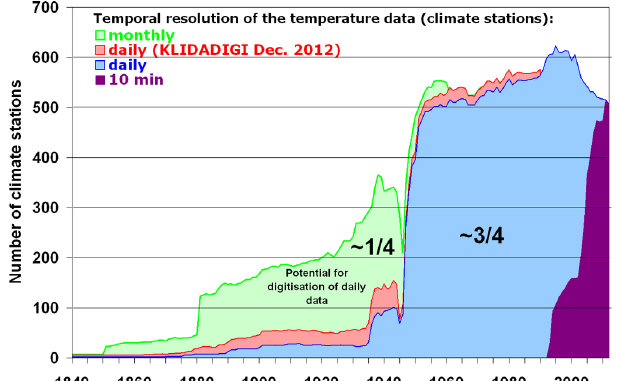
Figure 1. Number of temperature stations in the data base with spe- cific temporal resolution in the database. The blue area indicates the amount of data that was already digitally available at daily resolu- tion prior to the recent digitization e ff orts. The red area indicates the data that have already been digitized at daily resolution within the KLIDADIGI project. The green area indicates the amount of data with monthly resolution. This data can potentially be completed with daily resolution by digitizing further original